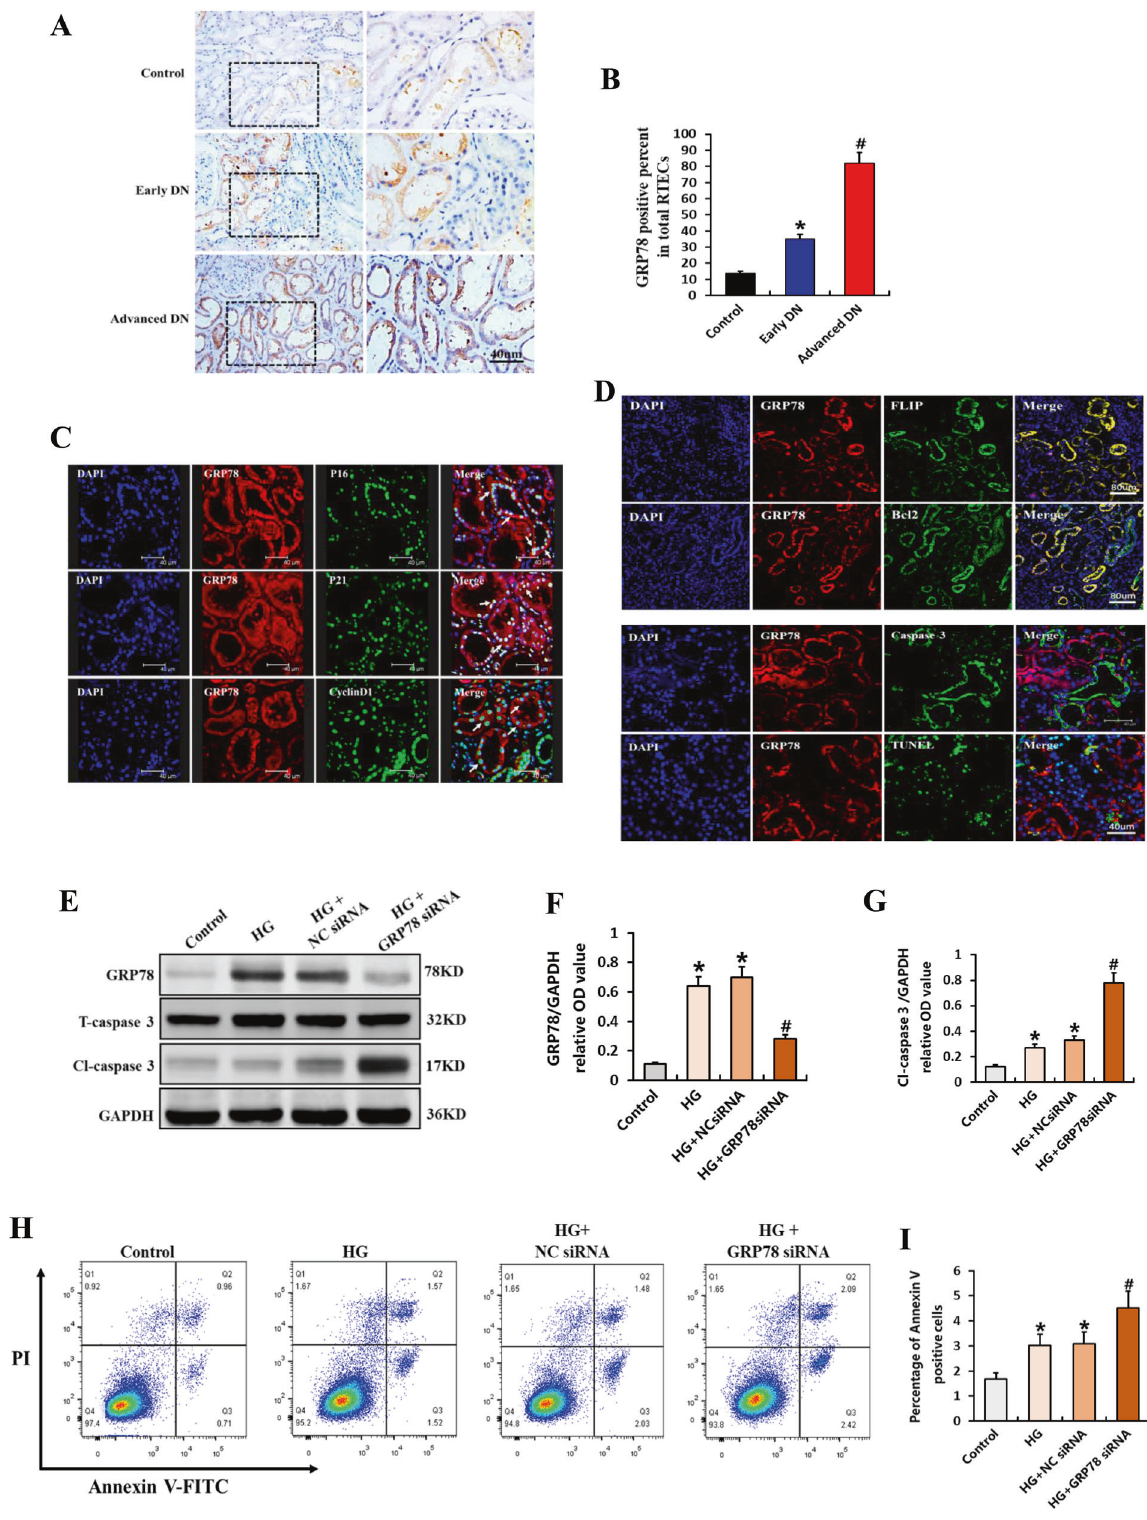
Fig. 6 Role of GRP78 in generating the apoptosis-resistant phenotype of senescent RTECs in DN. A Representative immunostaining micrographs showing the expression of GRP78 in controls and patients with DN. Scale bar, 40 μ m. B Quanti fi cation of the percentage of GRP78-positive RTECs. * P < 0.05 versus control; # P < 0.05 versus early DN. C Representative immuno fl uorescence staining for GRP78 (red) and p16, p21, cyclin D1 (green) in patients with DN. Arrows indicate co-expression in the same tubules. Scale bar, 40 μ m. D Immuno fl uorescence staining for GRP78 (red) and FLIP and Bcl2 (Scale bar, 80 μ m); GRP78 and caspase 3, TUNEL (Scale bar, 40 μ m). E Western blotting results for the expression of GRP78, total caspase 3, and cleaved caspase 3 in RTECs. F , G Expression levels quanti fi ed relative to GAPDH in different groups ( n = 4) * P < 0.05 versus control; # P < 0.05 versus HG. H , I Apoptosis rate as detected by fl ow cytometry and the percentage of Annexin V-positive RTECs ( n = 6). Data are expressed as the mean ± SD for each group. * P < 0.05 versus control; # P < 0.05 versus HG. Cell Death and Disease (2022)